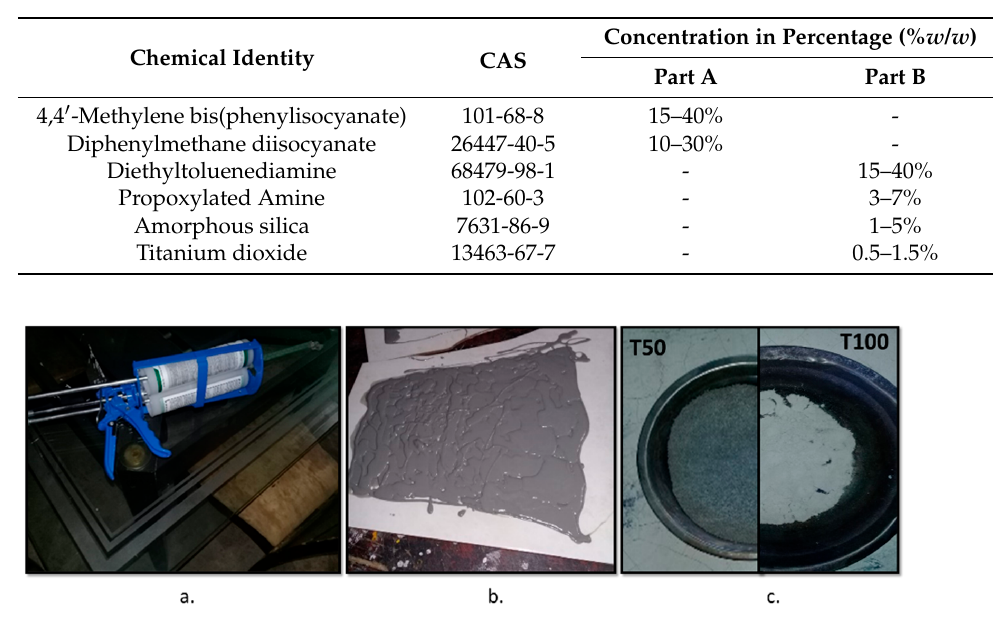
Figure 1. Preparation of PU: ( a ) EUCO QWIKJOINT 200 polyurea; ( b ) gray color of PU; ( c ) PU retained in sieve 50 and sieve 100.